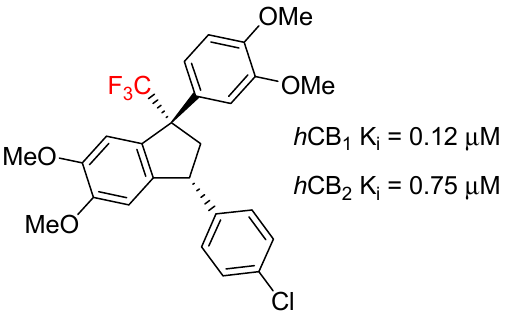
Figure 1. Cannabinoid receptor (CB 1 and CB 2 types) ligand properties of the CF 3 -indane (data from ref. [19]).